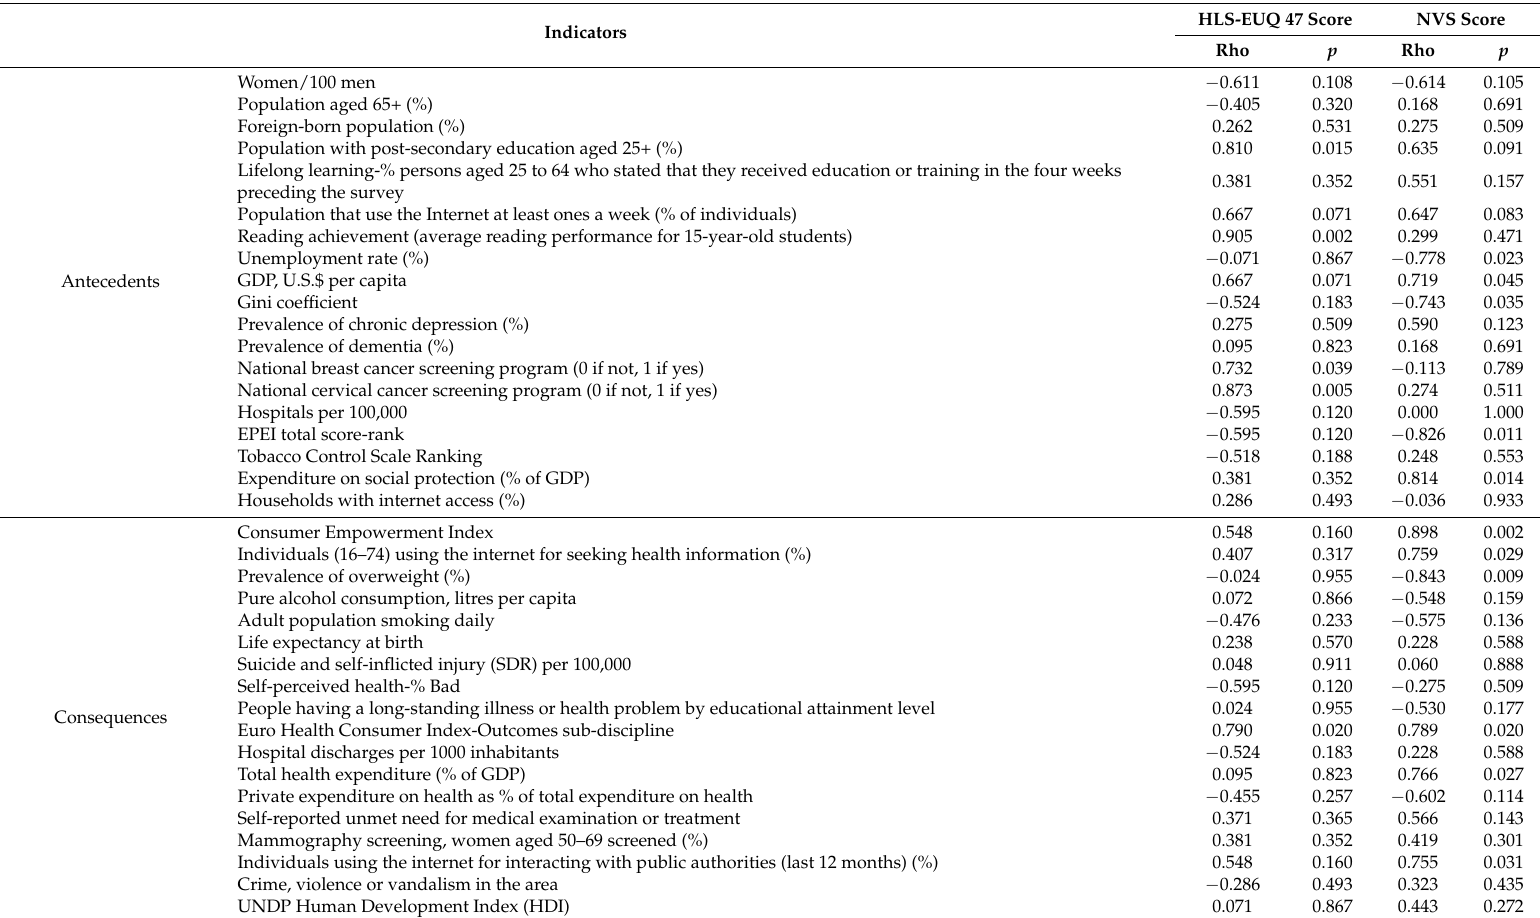
Table 4. Spearman’s correlation between HL (mean value of HLS-EU-Q47 and NVS scores), its antecedents and its consequences in the eight European countries of the HL